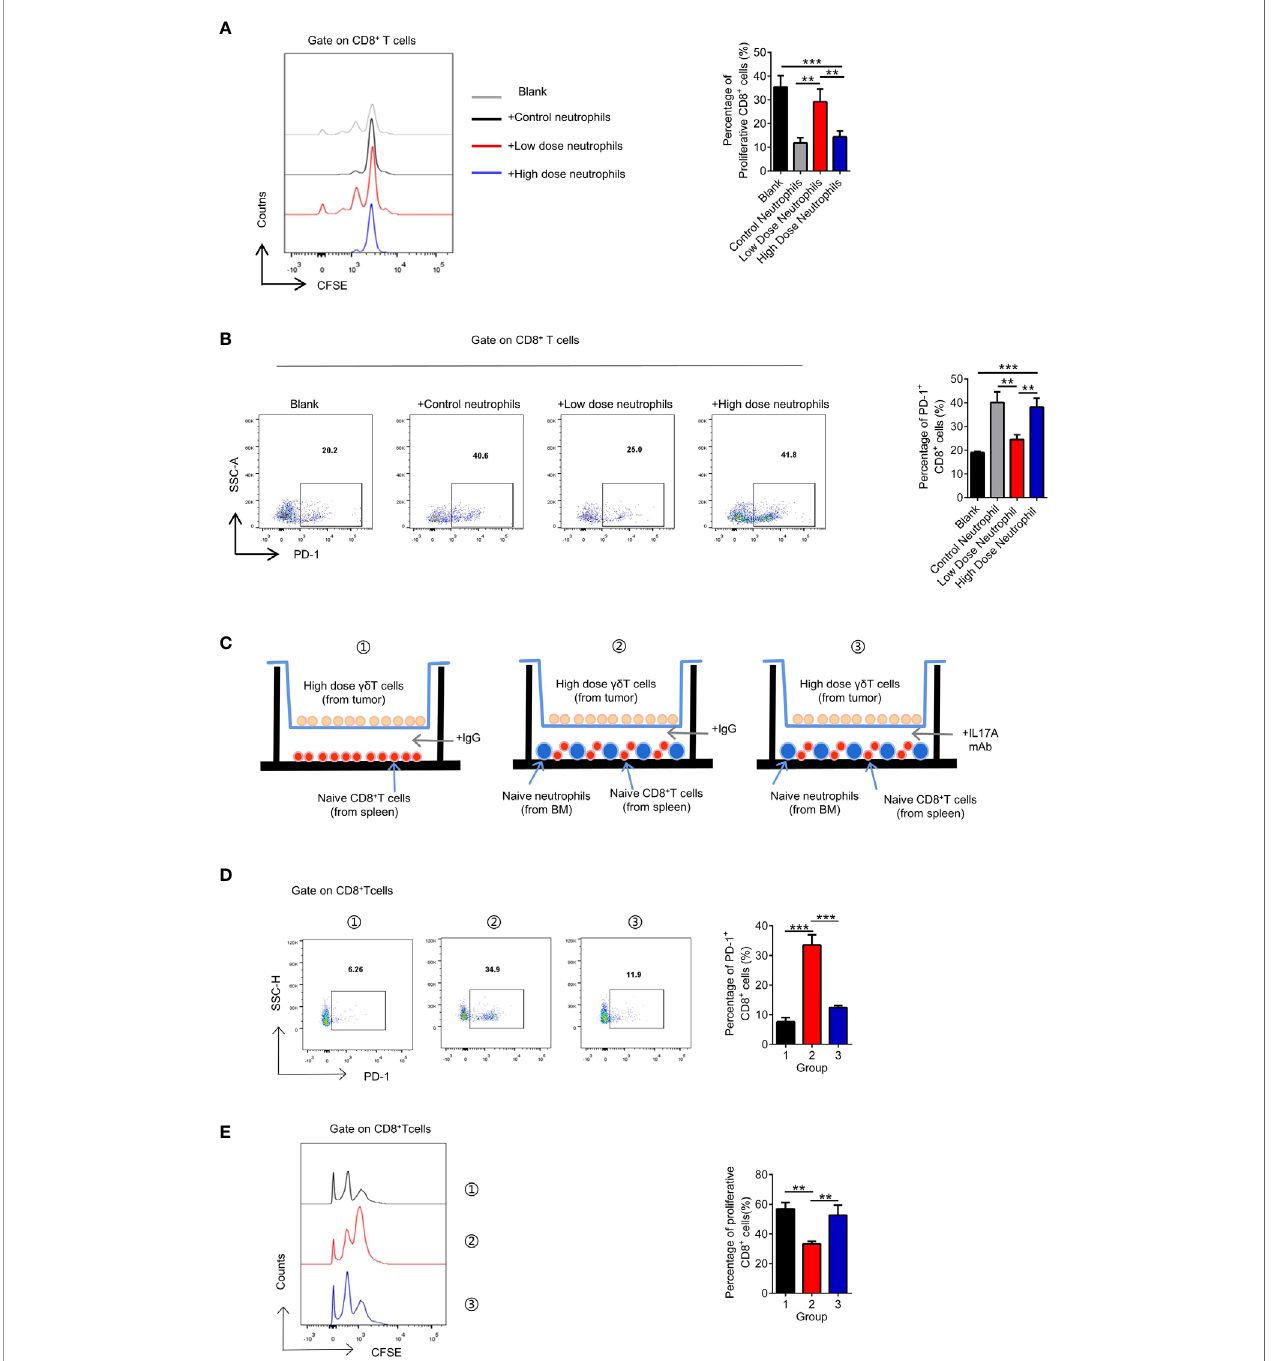
FIGURE 6 | The exhaustion of CD8 + T cells is attributed to neutrophils after high-dose VEGFR2-TKI therapy. (A, B) Quanti fi cation of proliferation of CD8 + T cells (CFSE low CD8 + ) (A) and PD-1 expression on CD8 + T cells (B) after co-culture with different groups of neutrophils sorted from the tumor after VEGFR2-TKI therapy. CD8 + T cells were derived from naive spleens. (C) Schematic illustration of CD8 + T cells and neutrophils indirect co-cultrured with high dose of gd T cells sorted from the tumor after VEGFR2-TKI therapy shown in 6D and 6E. CD8 + T cells were derived from naive spleens. Neutrophils were derived from bone marrow. Transwell chamber=0.4 m m. (D, E) Quanti fi cation of PD-1 expression on CD8 + T cells (D) and proliferation of CD8 + T cells (CFSE low CD8 + ) (E) after co-cultured with neutrophils and high dose of gd T cells sorted from the tumor after VEGFR2-TKI therapy shown in 6C. Data are presented as the means ± SD from one representative experiment. Similar results were obtained from three independent experiments, n=4 mice each group, unless indicated otherwise. Statistical analysis was performed by one-way ANOVA. **p < 0.01, and ***p < 0.001. See also Supplementary Figure S6